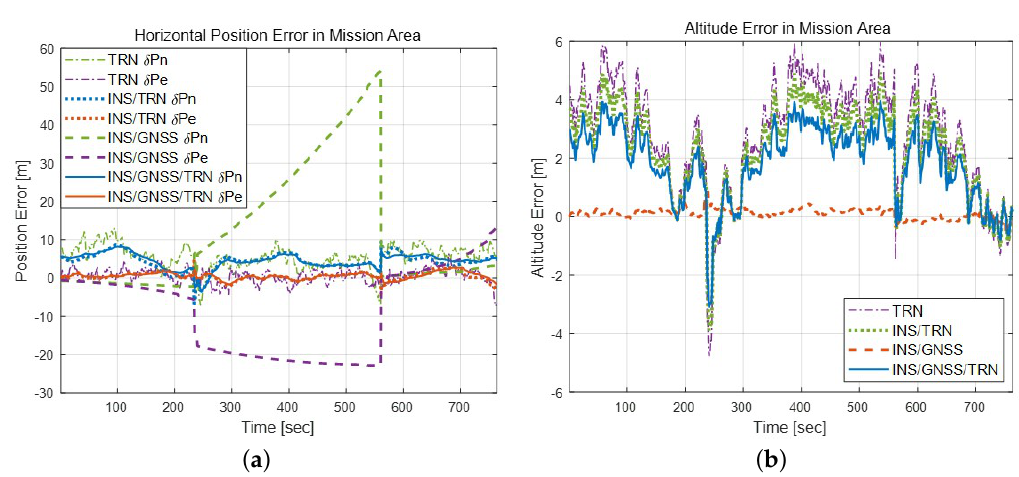
Figure 8. Results of SIL Test 1 when GNSS is unavailable in the mission area. ( a ) Horizontal position error. ( b ) Altitude